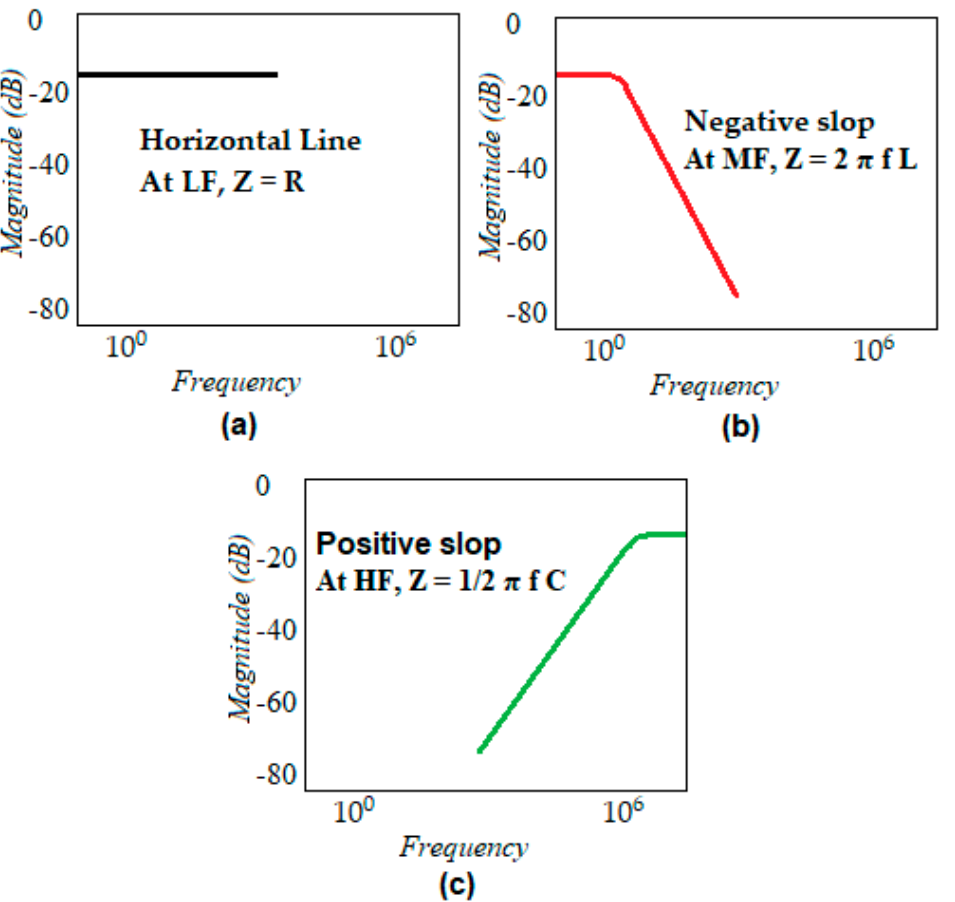
Figure 7. RLC parameters and their contribution to the measured FRA. ( a ) LF range (from 10 Hz to